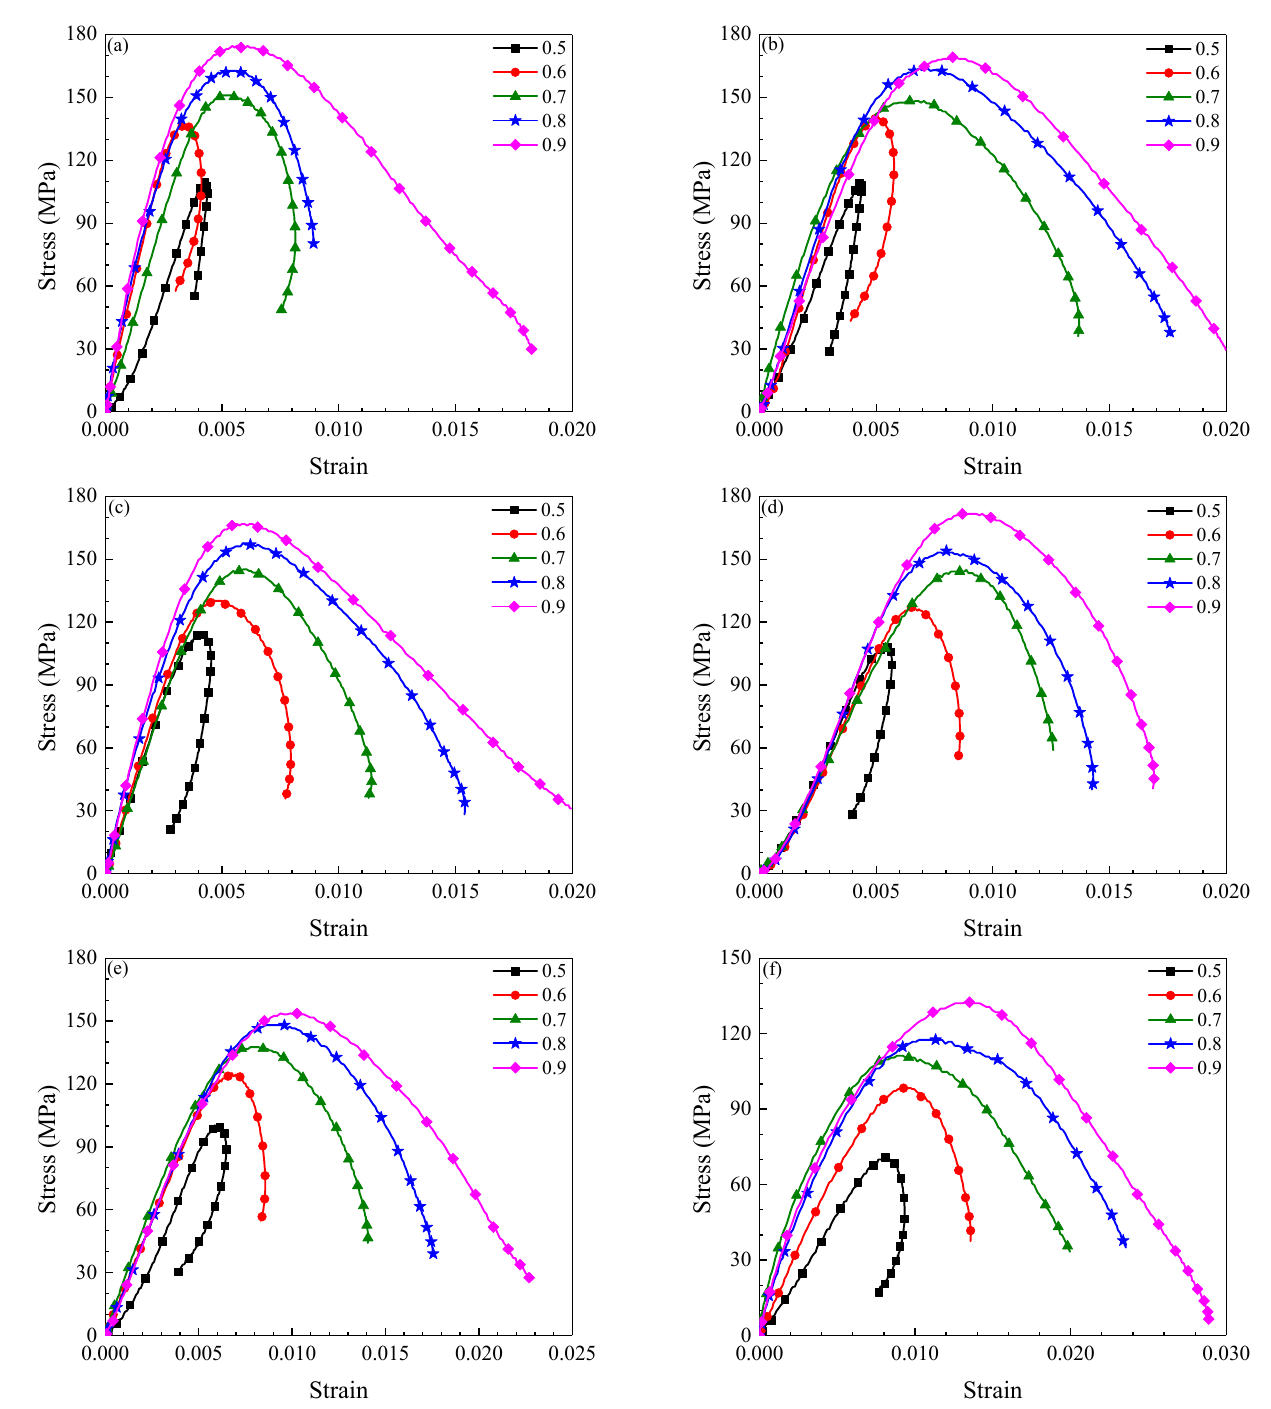
Figure 7. Dynamic stress-strain curves of granite at different temperature and impact gas pressure.